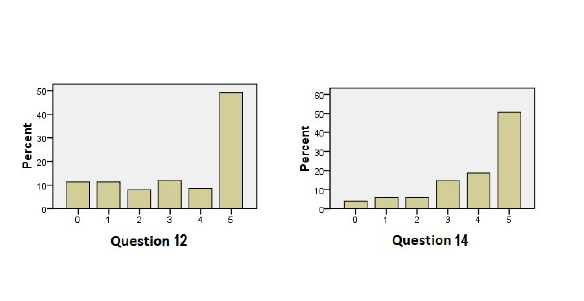
Figure 5: Equal segments